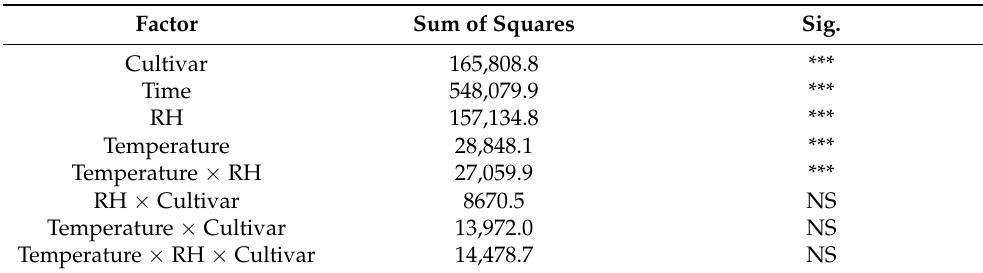
Table 2. Analysis of variance for the effects of cultivar, relative humidity (RH), temperature, or their interaction on pollen viability of Olea europaea